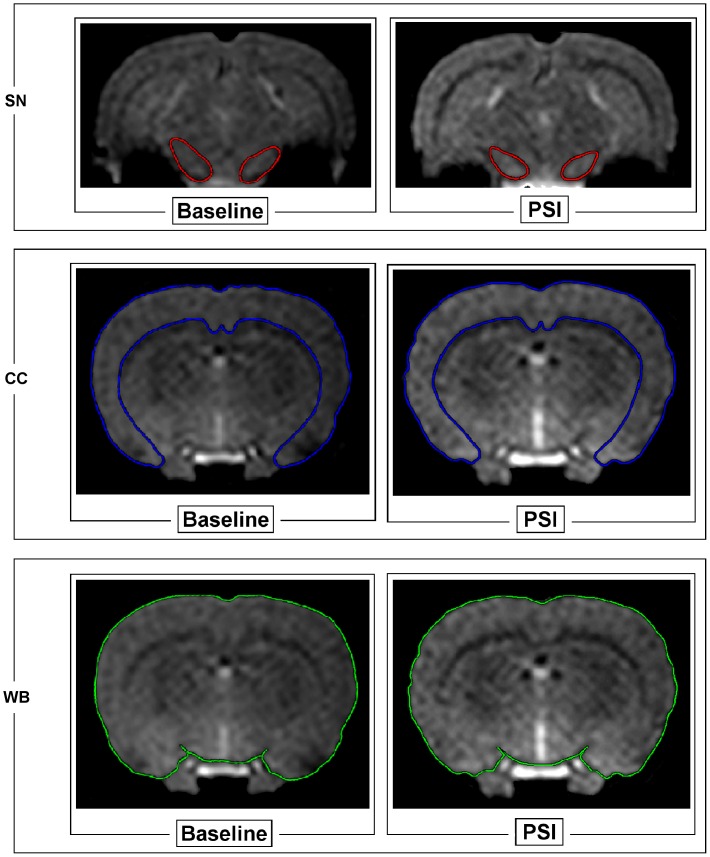
Coronal images of brain areas of a representative PSI-treated animal by using T2*-weighted gradient-echo sequences.Top panel shows substantia nigra area (SN, delimited by the red frame) before (left) and after (right) PSI treatment. Notice the rim of low T2* signal intensity which characterizes the external margin of SN. Middle panel shows cerebral cortex area (CC, delimited by the blue frame) before (left) and after (right) PSI treatment. Bottom panel shows whole brain area (WB, delimited by the green rim) before (left) and after (right) PSI treatment. CC and WB areas were drawn on a coronal slice passing through the nucleus striatum.